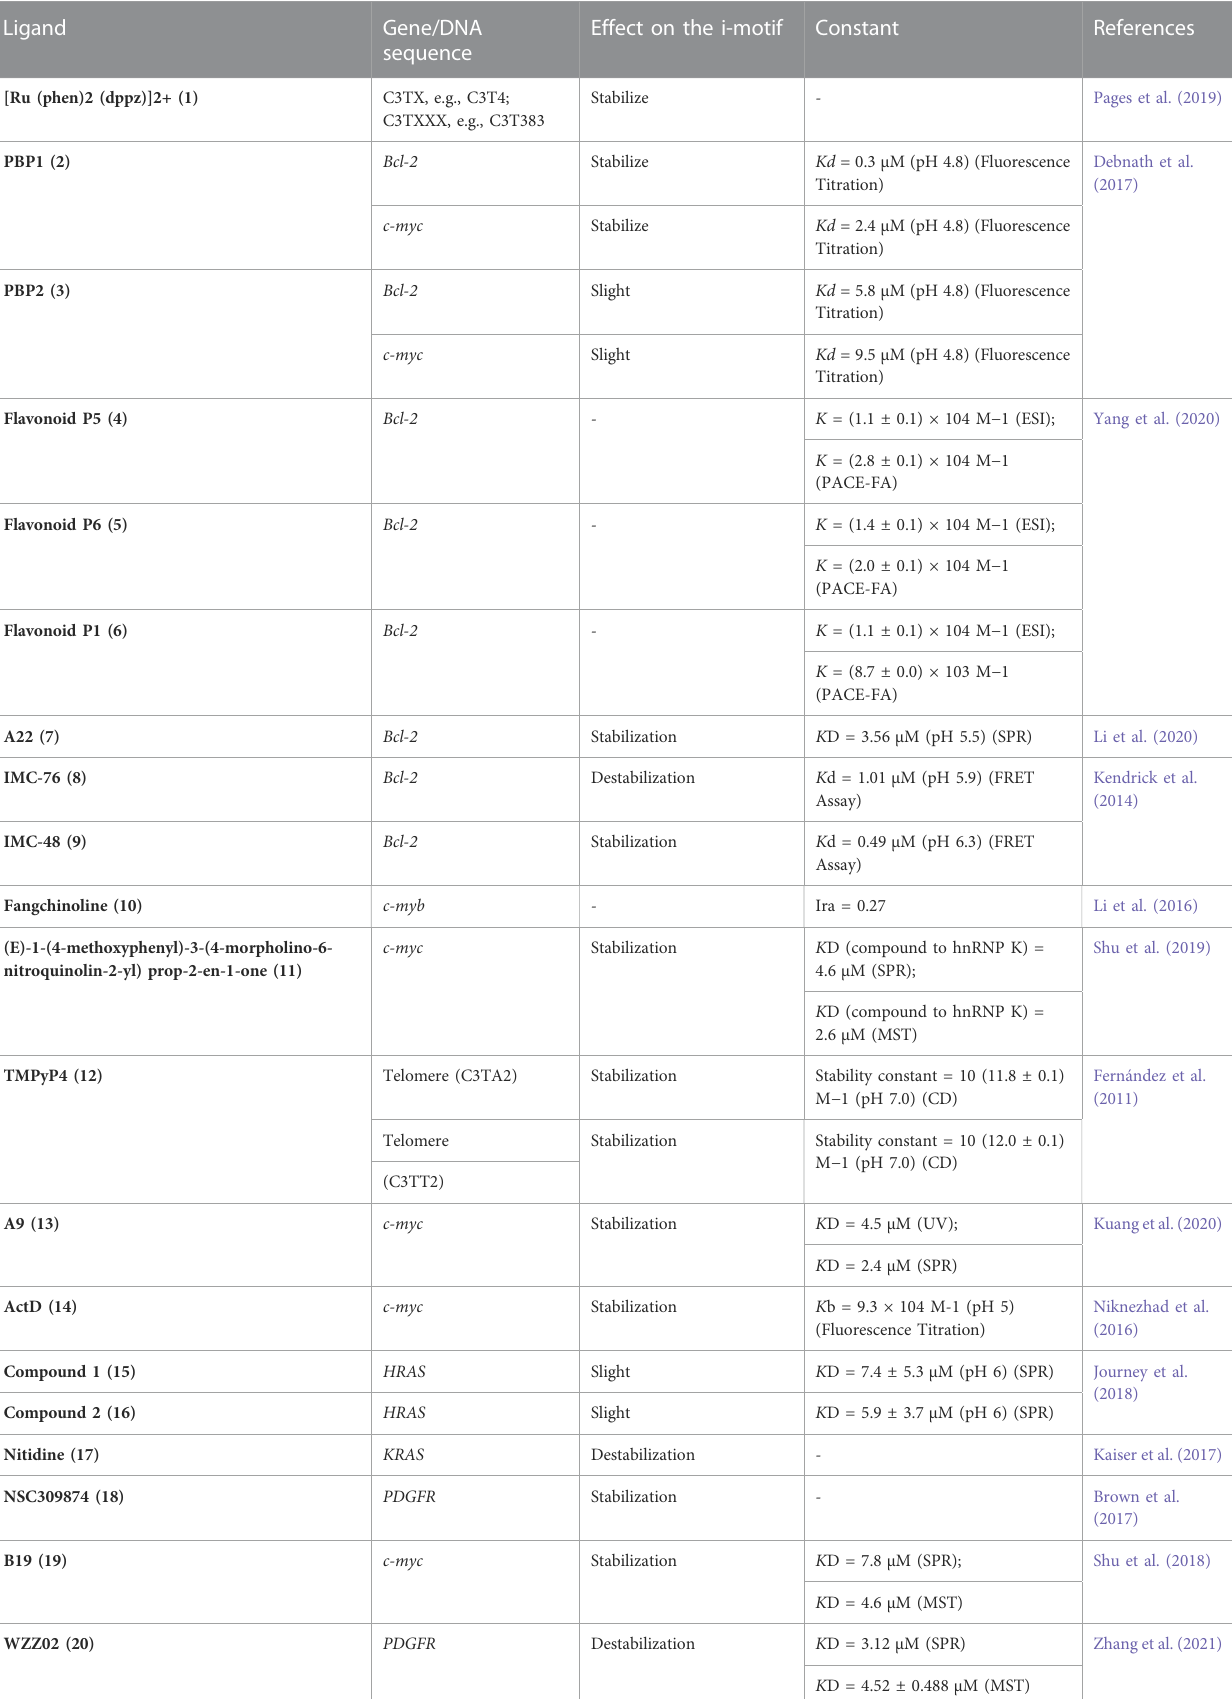
TABLE 1 Summary of some properties of i-motifs